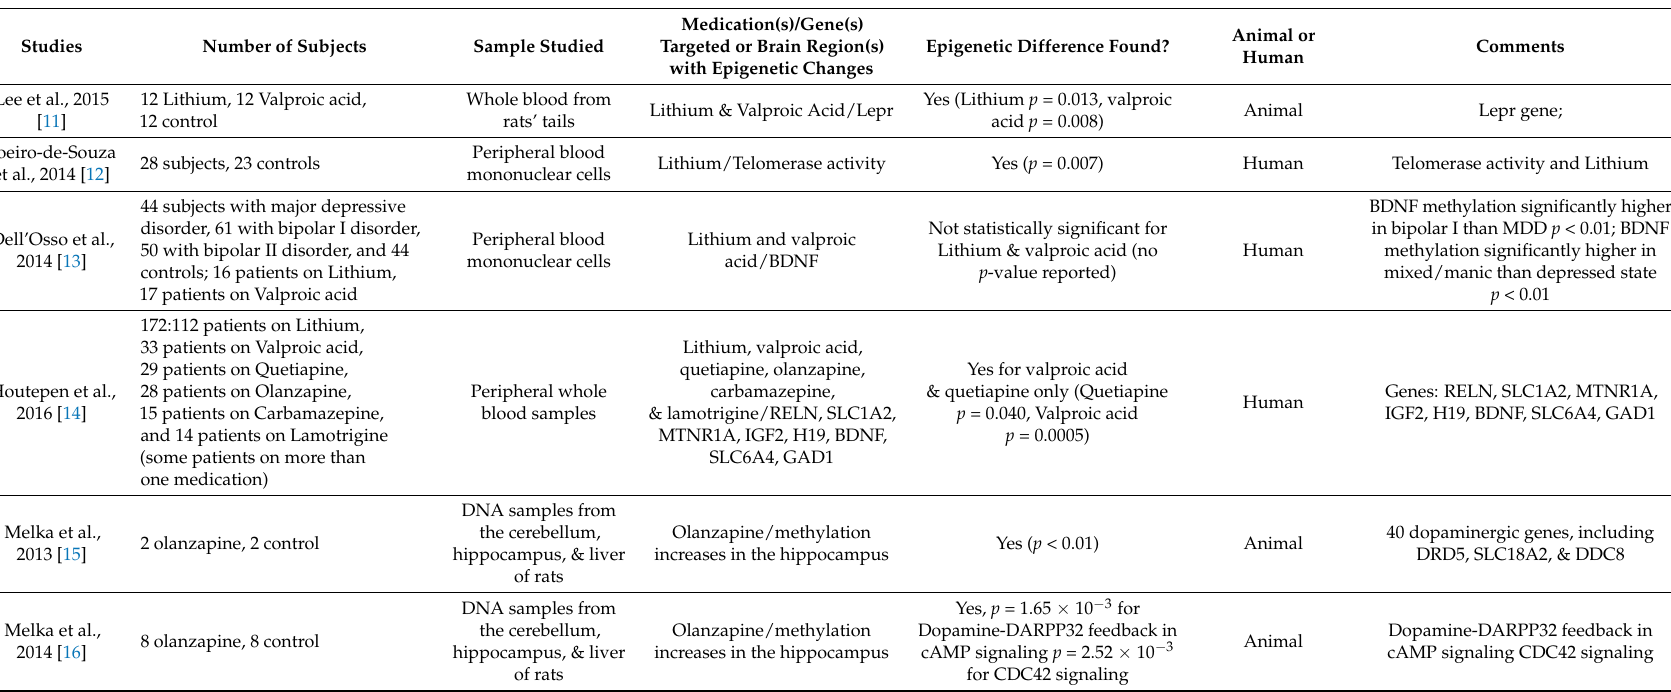
Table 1. Studies examining the epigenetic effects of psychopharmacological agents for treating bipolar